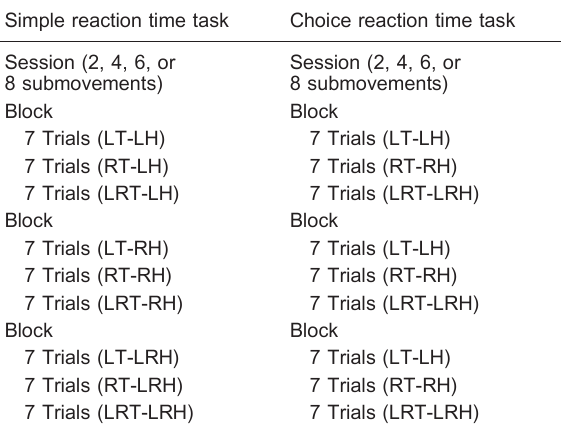
Table 1. Experimental